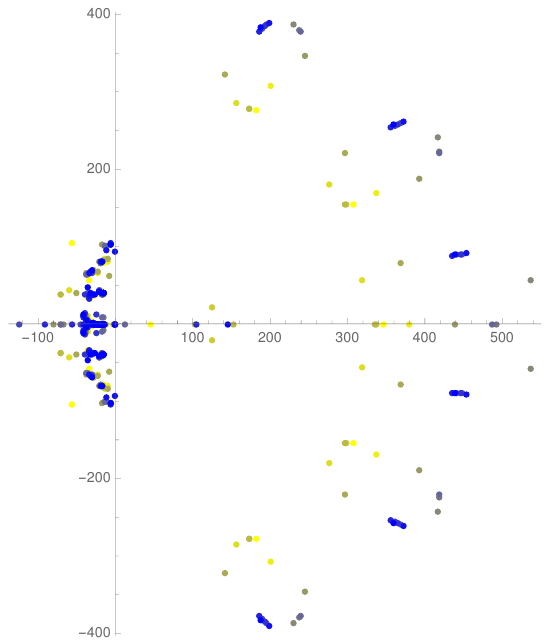
Figure 2 . Poles of the Pad(cid:19)e approximants P [ E ( (cid:23) ) ]( (cid:16) ) of the Borel transform for the perturbative ground state energy for F 2 for orders from 70 to 100. The poles which are more yellow are of lower order, while the poles which are more blue are of higher order Pad(cid:19)e approximants. order